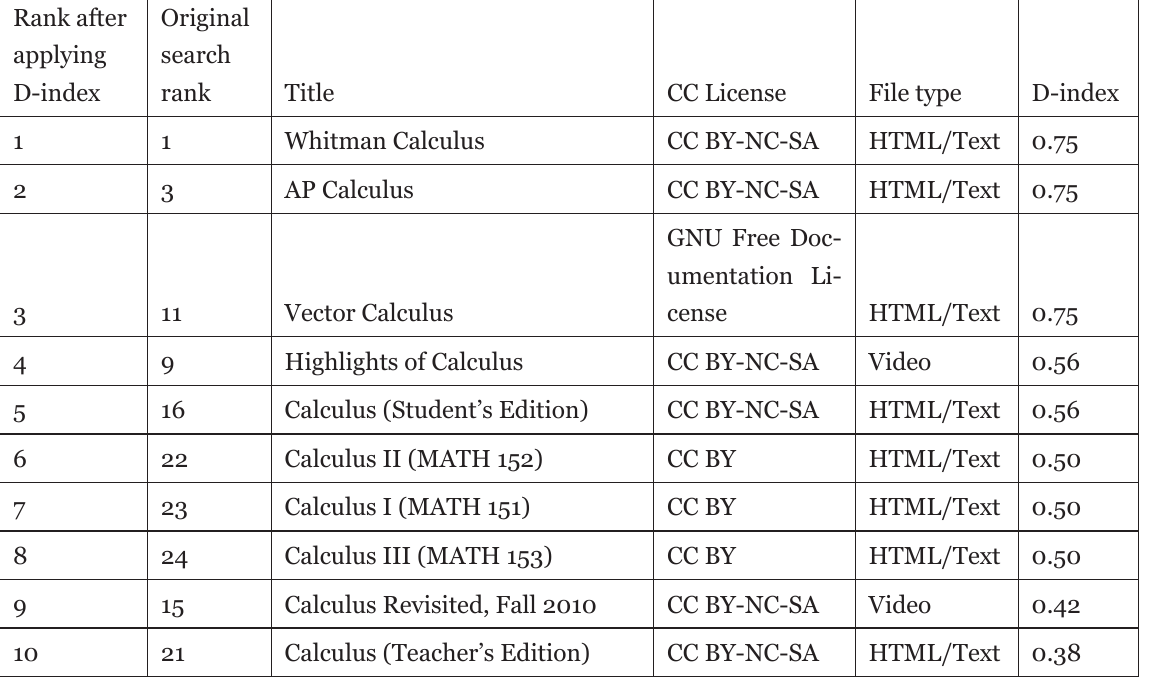
Top Ten Results when D-index is Applied to the Results Returned by OER Commons Rank